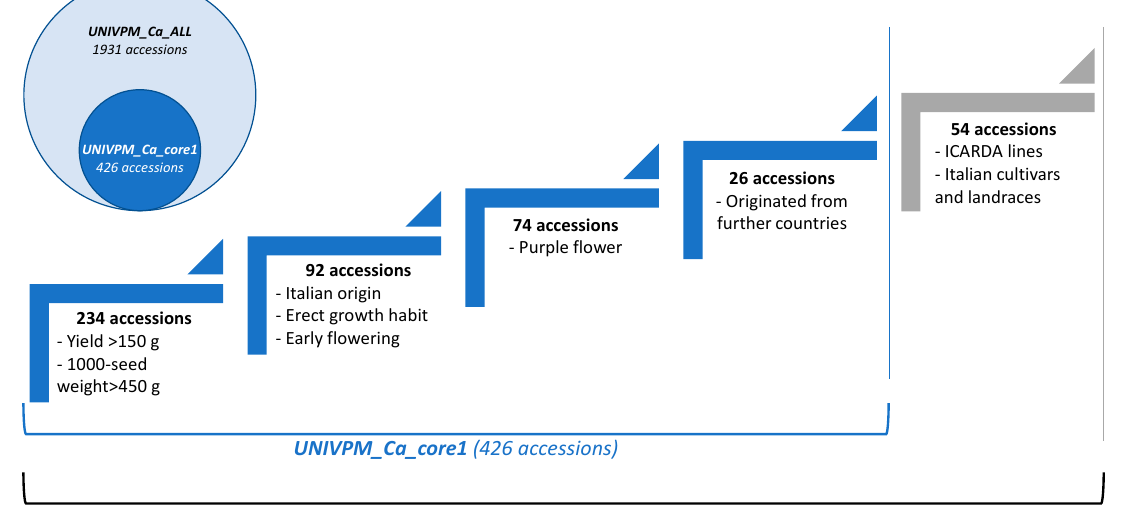
Figure 1. Selection steps carried out in the development of UNIVPM_Ca_core1 and UNIVPM_Ca_core2 ; SW, seed weight.